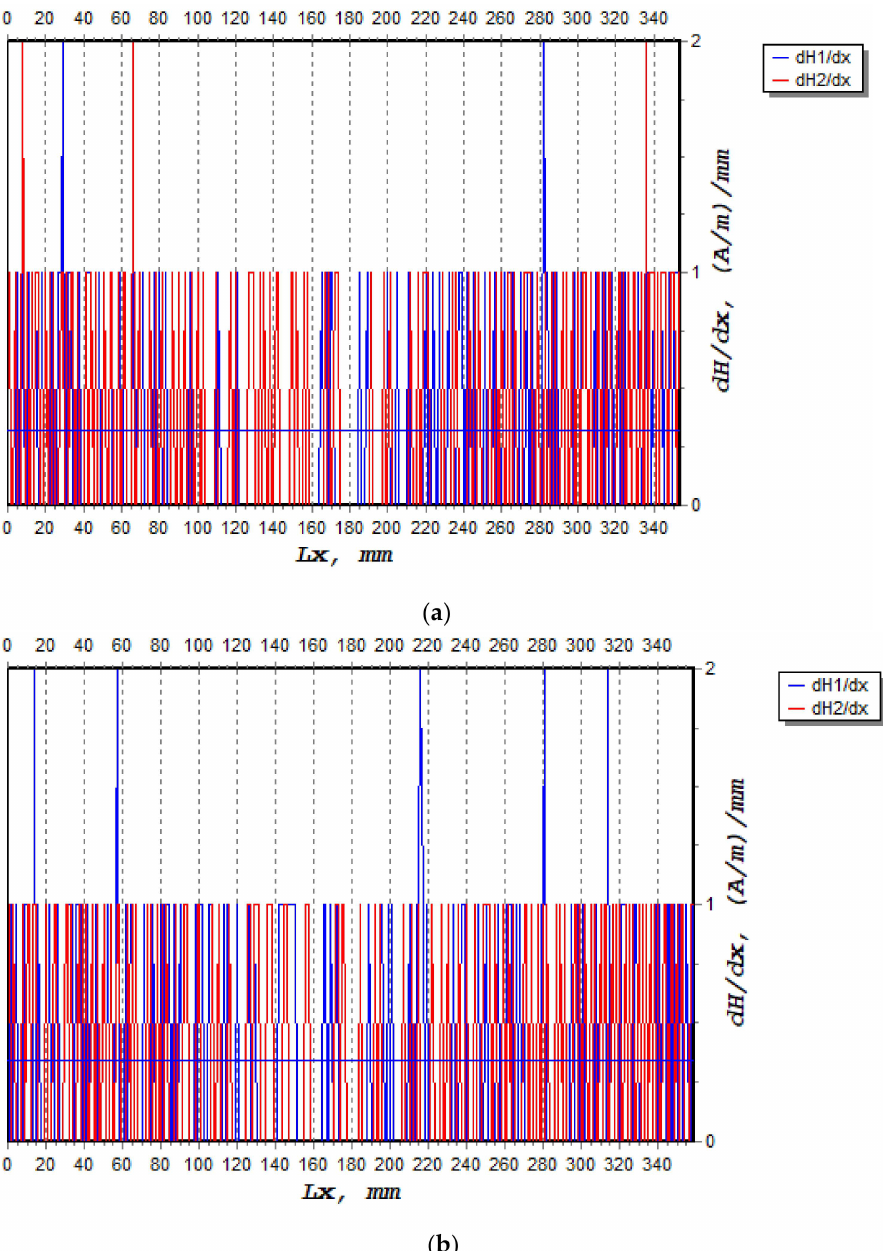
Figure 8. The normal compound gradient signals, dH(y)/dx that occurred on the beam when subjected to cyclic loading: ( a ) 1400 cycles, ( b ) 2800